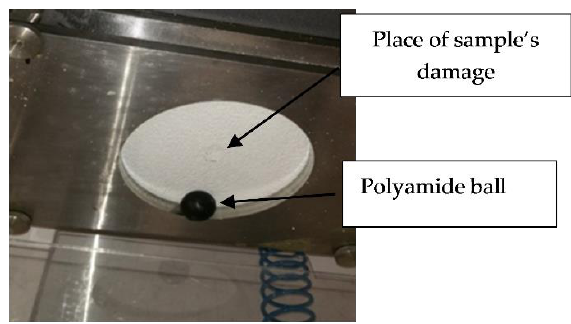
Figure 4. Results of hail resistance tests for sets with different adhesives and the same mesh: ( a ) in reference to the maximum velocity of the test ball, which does not cause the sample ’s damage, ( b ) calculated as the maximum kinetic energy of the test ball, which does not cause the sample damage.